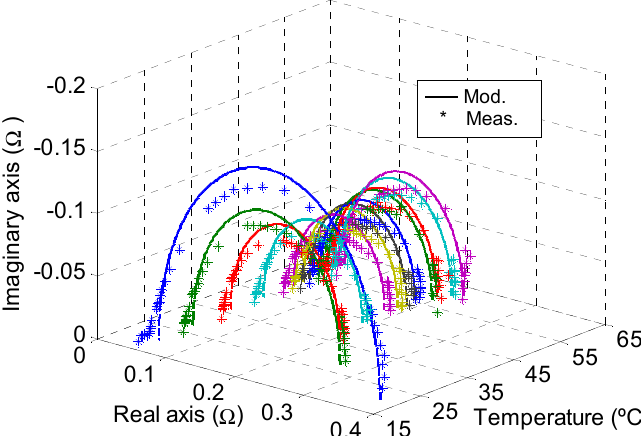
Figure 7. EIS results measured (Meas.) and modelled (Mod.) for a temperature range from 20 to 62